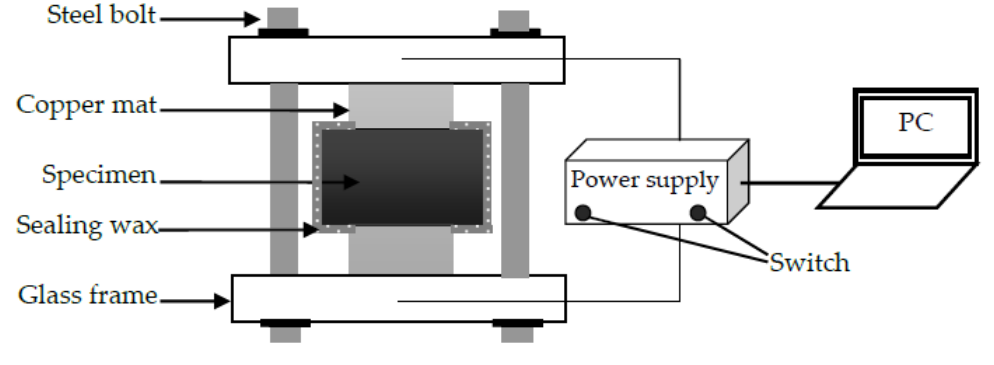
Figure 13. Schematic of test device.